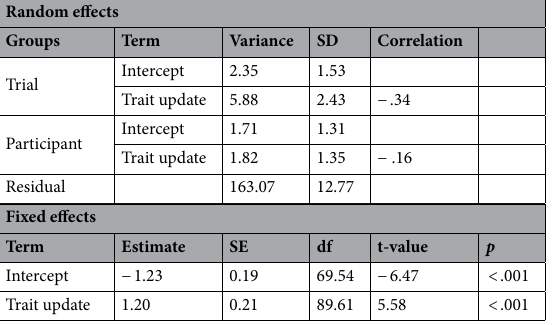
Table 2. Model summary for predicting updates to mental state